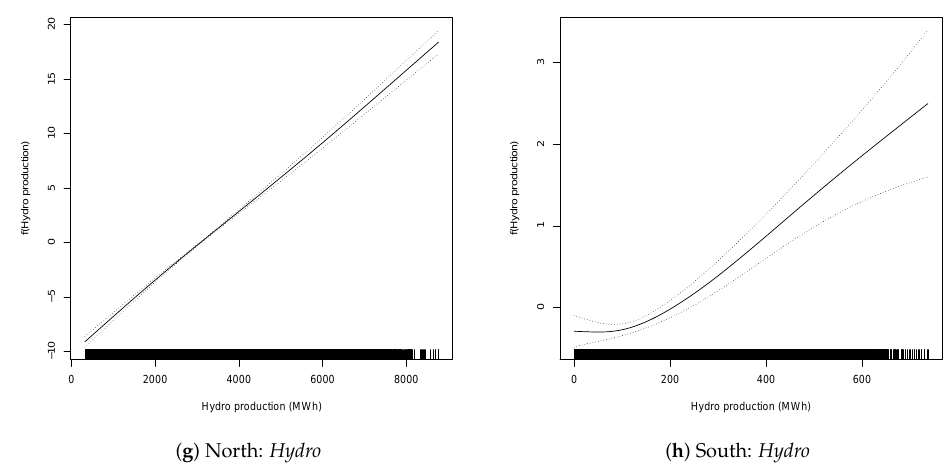
Figure 4. In–sample estimation results of the non-parametric additive model for the conditional mean of electricity prices. For both zones, each panel plots the estimated function f j ( · ) for the renewable energy production